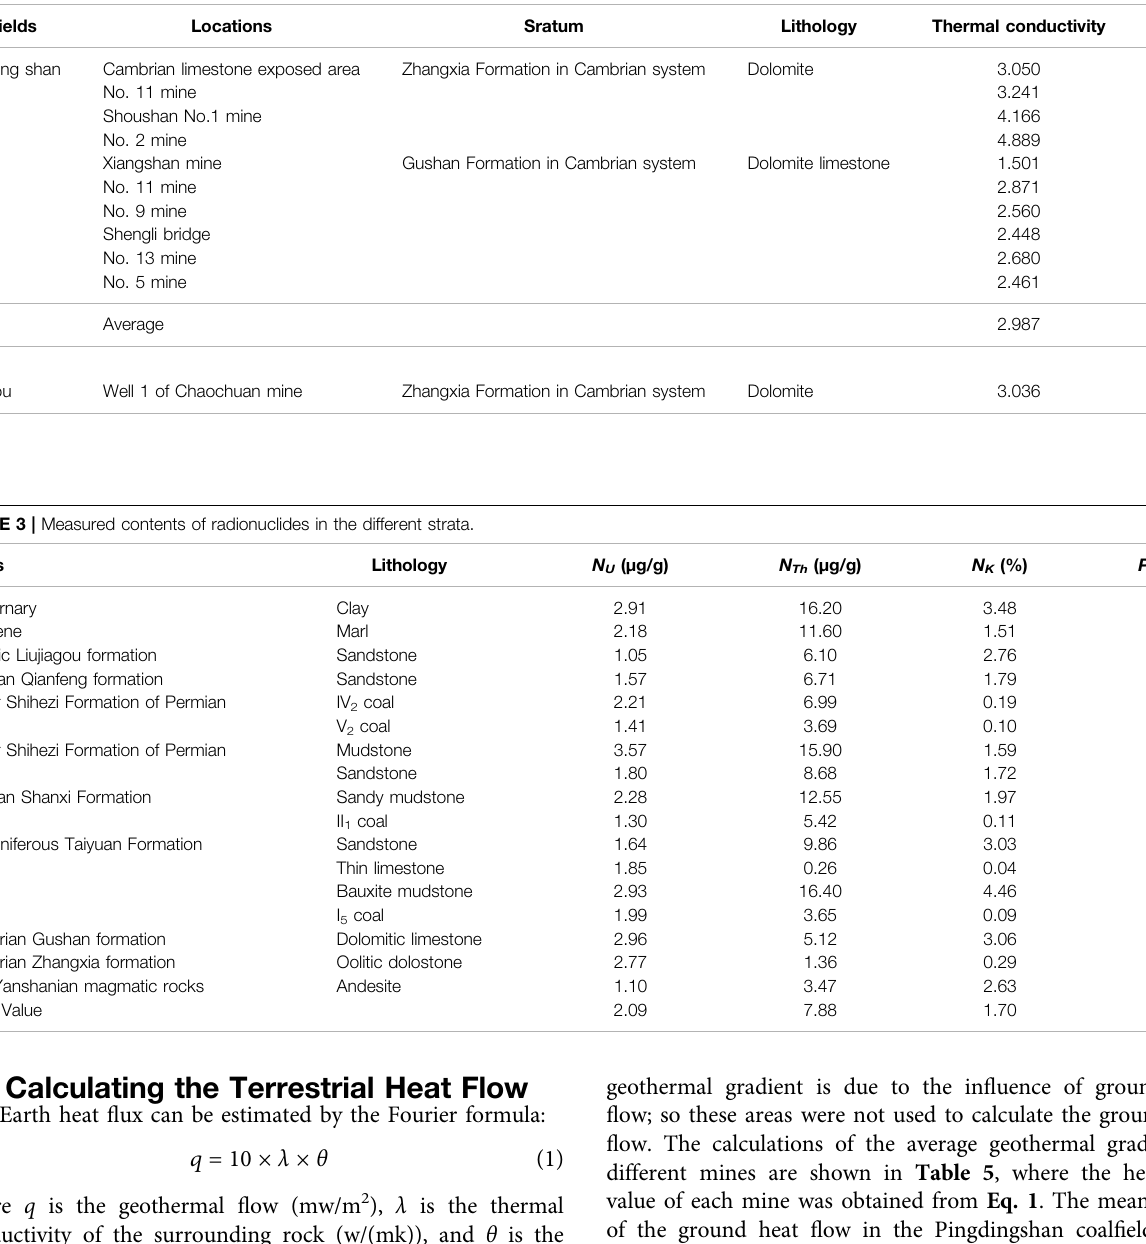
TABLE 2 | Thermal conductivity of the Cambrian limestone (W/mK).